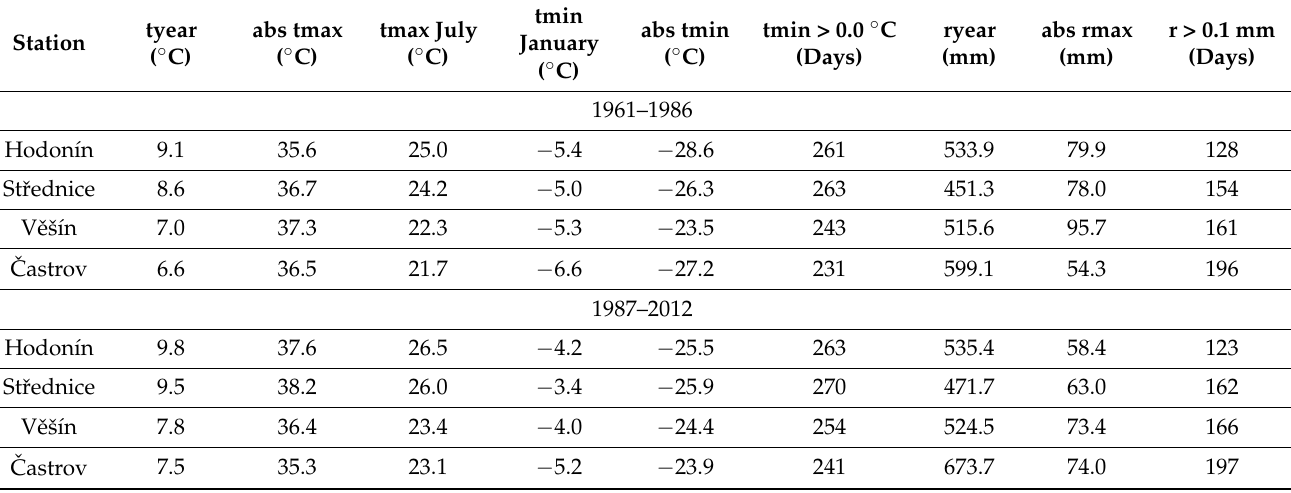
Table 2. Climatological characteristics of the phenological